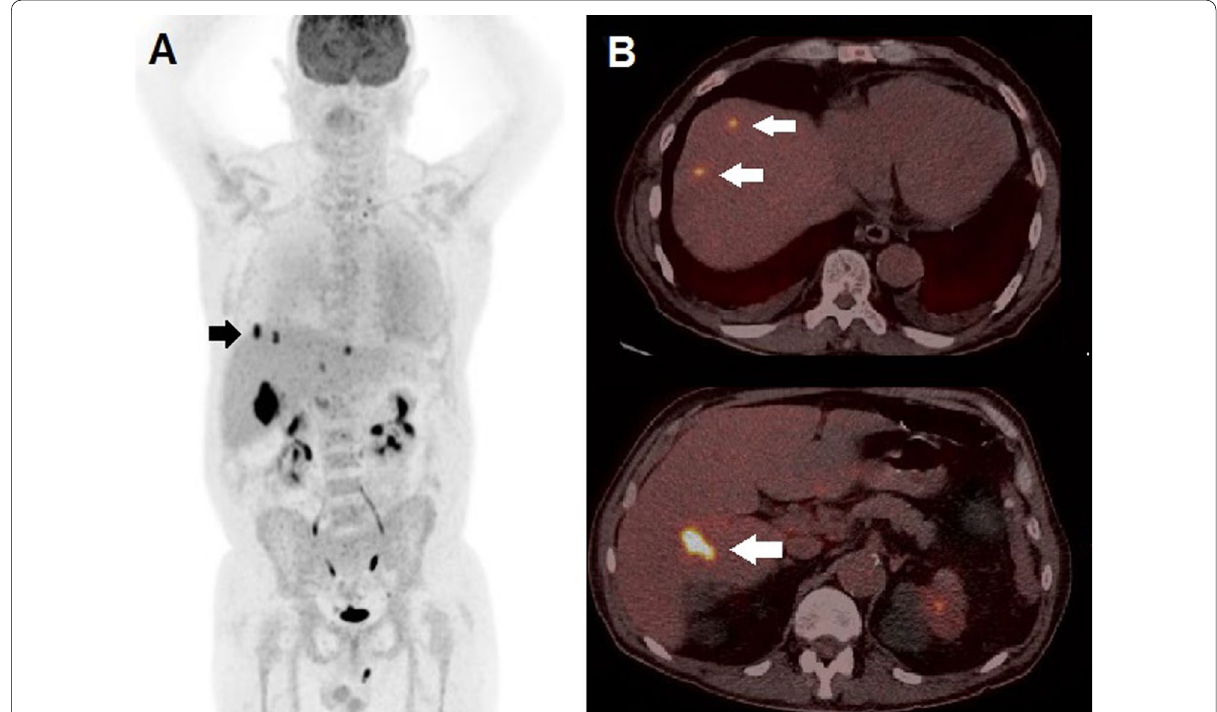
Fig. 3 18 F-FDG PET/CT Whole Body ( a ) performed after splenectomy demonstrated focuses of tracer uptake in the liver, as then detailed by fused PET/CT axial slices ( b ) that demonstrated hypermetabolic lesions (white arrows) in the hepatic dome (upper row) and in the 6th hepatic segment (lower row), with SUVmax of